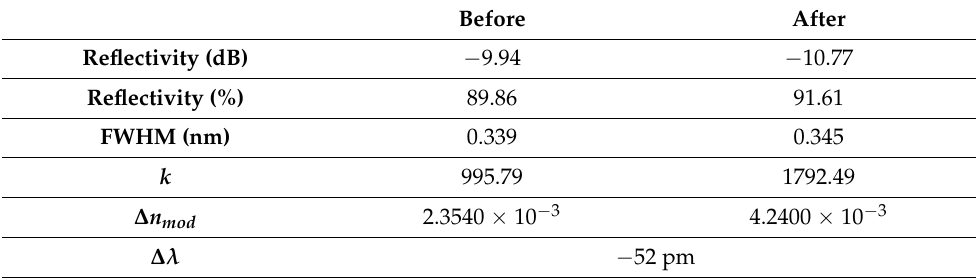
Table 4. Spectral characteristics of the PlbPl -FBG before and after exposure to electron radiation. Before